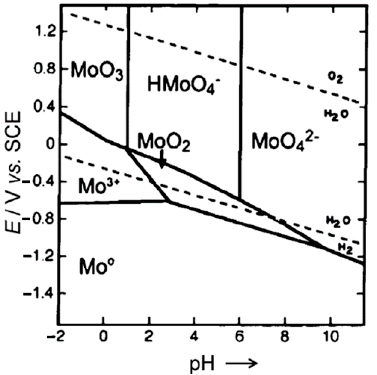
Figure 4. E-pH diagram for molybdenum taken from [41].